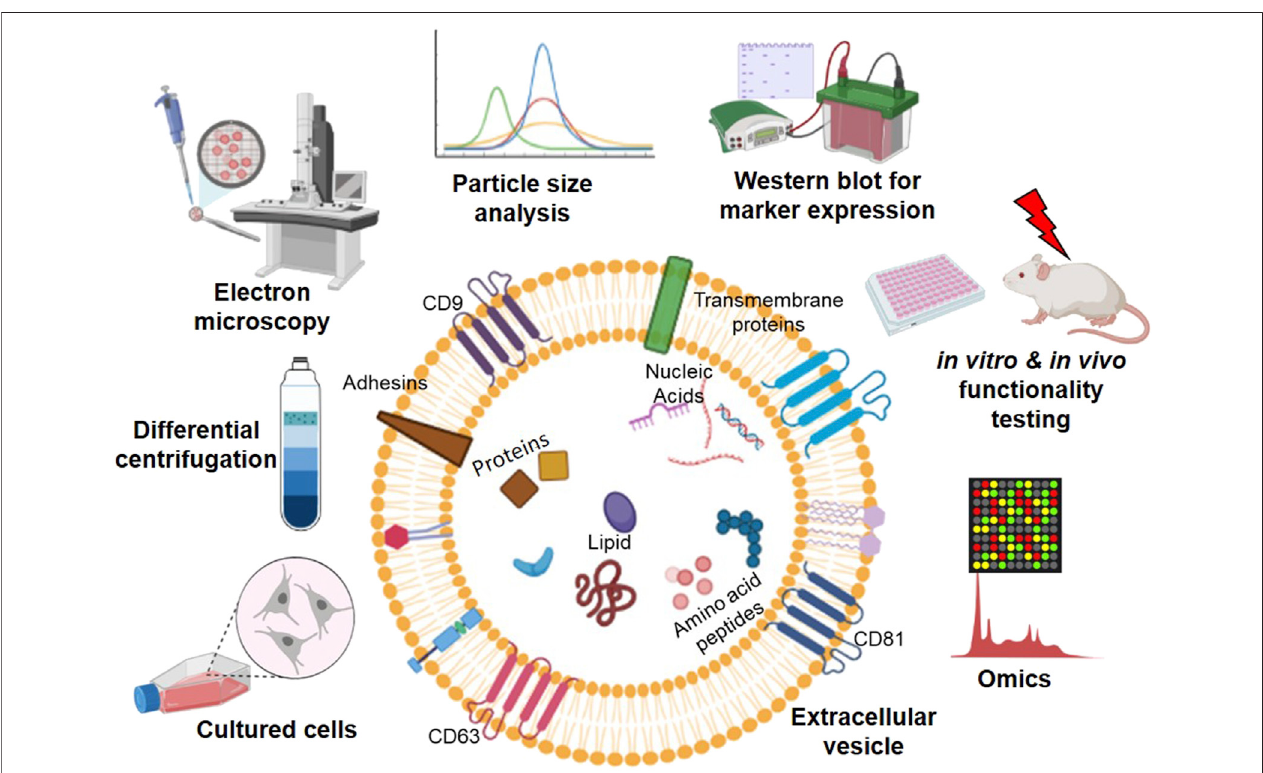
FIGURE 2 | An overview of work fl ow in studying extracellular vesicles (EVs). EVs contain a lipid bilayer membrane that encapsulates various molecules, including proteins,nucleicacids, amino acids/peptides, and lipids, forcell-to-cell communication. EVs aresecretedfrom the cultured cells from various sources and isolated from the cell culture medium using ultracentrifugation. The isolated EVs can be characterized by (left to right on the top of EV) electron microscopy, particle size analysis, Western blotting, in vitro and in vivo functional testing, and high throughput-omics analysis (Graphics adapted from BioRender.com).